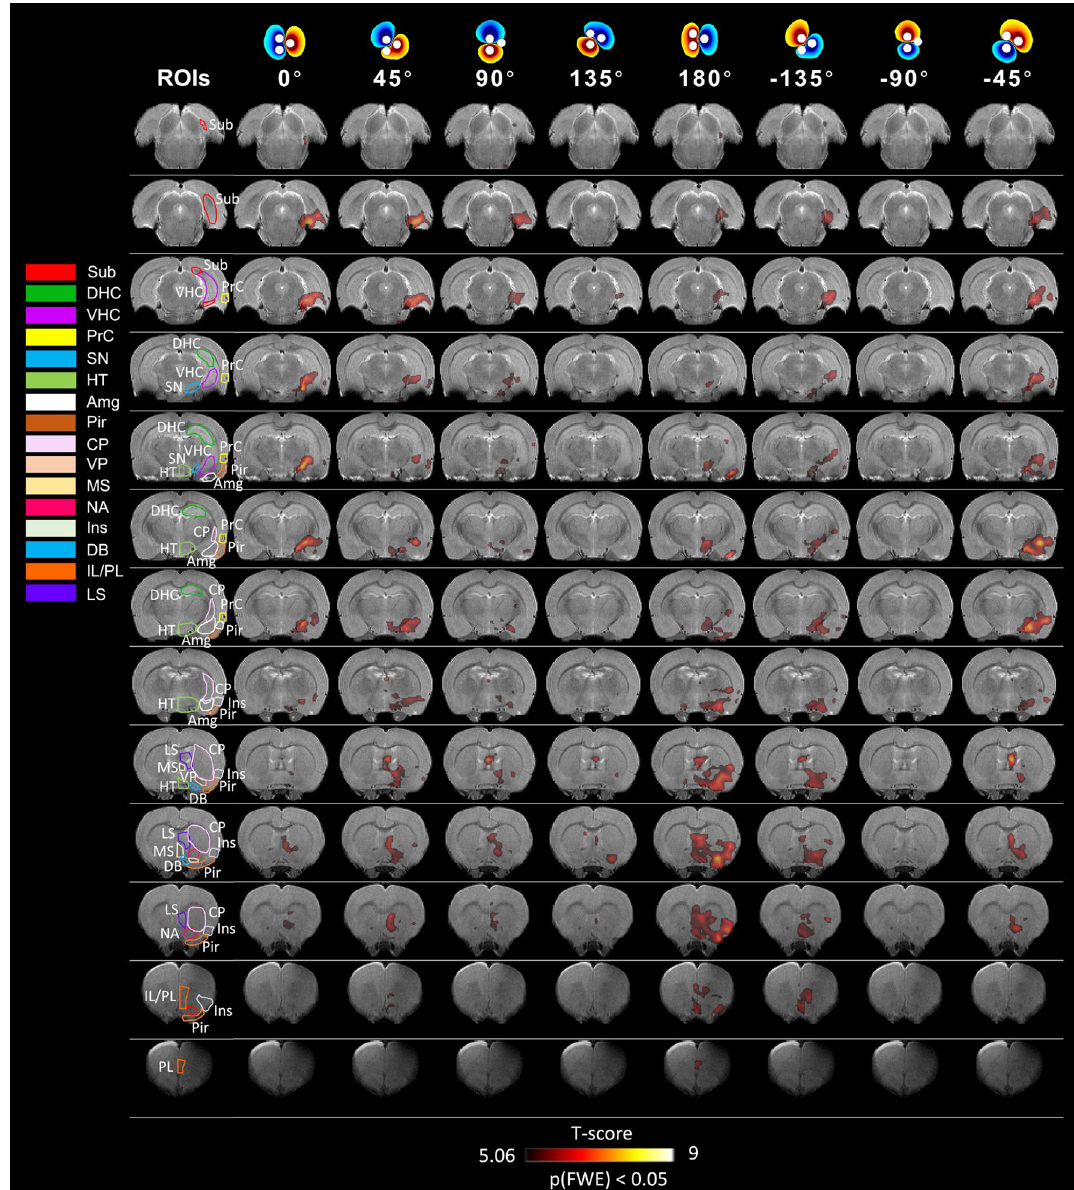
Figure 2. Main effects of OS-DBS in the right EC for all stimulation angles (n = 10). Activation maps were obtained by the one-way within subject ANOVA model (p ≤ 0.05, FWE corrected). Amg: amygdala, CP: caudate- putamen, DB: diagonal band, DHC: dorsal hippocampus, VHC: ventral hippocampus, HT: hypothalamus, IL/ PL: infralimbic/prelimbic cortices, Ins: insula, LS: lateral septum, MS: medial septum, NA: nucleus accumbens, Pir: piriform cortex, PrC: perirhinal cortex, SN: substantia nigra, Sub: subiculum, VP: ventral pallidum. Coronal brain images are displayed in neurological convention (left corresponds to the left side of the brain). Stimulation angles are shown on top. Stimulation frequency was 20